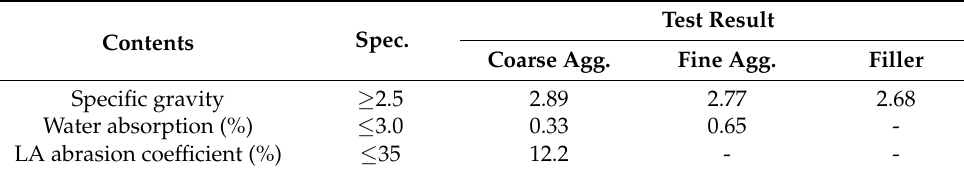
Table 2. Basic properties of the used